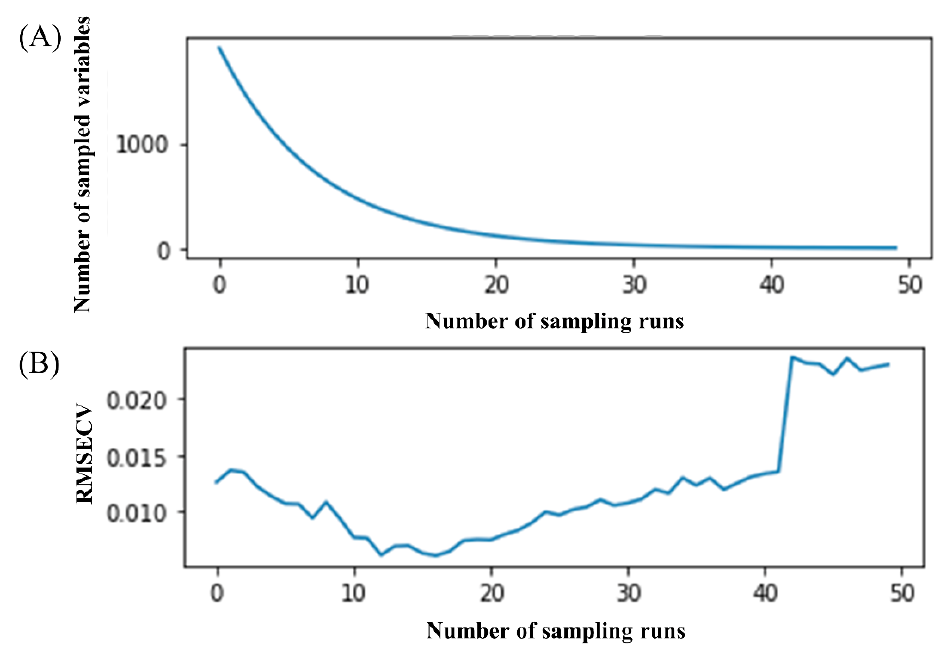
Figure 5. The process of selecting characteristic bands of Raman spectrum by CARS. ( A ) Number of sampled variables changed according to the number of sampling runs; ( B ) RMSECV values changed according to the number of sampling runs.